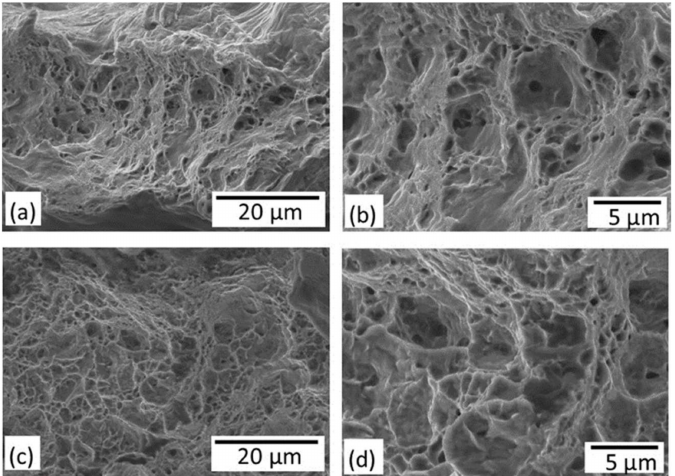
Figure 12. SEM micrographs showing fracture surfaces of ( a , b ) 100 µ m, 50 W, and 20 mm/s, and ( c , d ) 200 µ m, 100 W, and 30